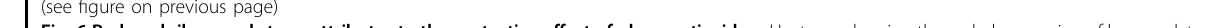
Fig. 6 Reduced ribosomal stress attributes to the protective effect of glucocorticoids. a Heatmap showing the scaled expression of key regulators and/or effectors associated with ribosomal transcription ( MAX and TAF1C ), ribosomal processing and transporter ( NPM1 and XPO1 ) and translation initiator ( EIF2B1 , EIF2B2 , EIF3A , and EIF4E ) in C3 of all groups. b – d Line graphs showing the expression dynamics of total ribosomal protein genes (RPL + RPS), large ribosomal protein genes (RPL) and small ribosomal protein genes (RPS) in all ( b ), RPL mutant ( c ) and RPS mutant ( d ) samples across clusters. Different donor types are coded with the indicated color. e A hypothetical model illustrating altered biological processes that lead to cellular distress and pathogenesis of DBA (upper). The imbalance between the innate fast cell cycle and insuf fi cient protein biosynthesis, which results from RP mutation, could trigger DNA replication stress in the BFU-E cells of DBA patients; and concomitantly elicit DNA damage-induced P53 activation and apoptosis. The lower panel shows a proposed schematic of the therapeutic mechanism of GCs. GC administration elevates IFN signaling, which attenuates cell proliferation by regulating the activity of cell cycle regulators and modulators (e.g., MYC , CDK4 , and CDK6 ). It also alleviates ribosomal stress via the repression of MYC , thereby rectifying the imbalance and ultimately ameliorating apoptosis and promoting cell